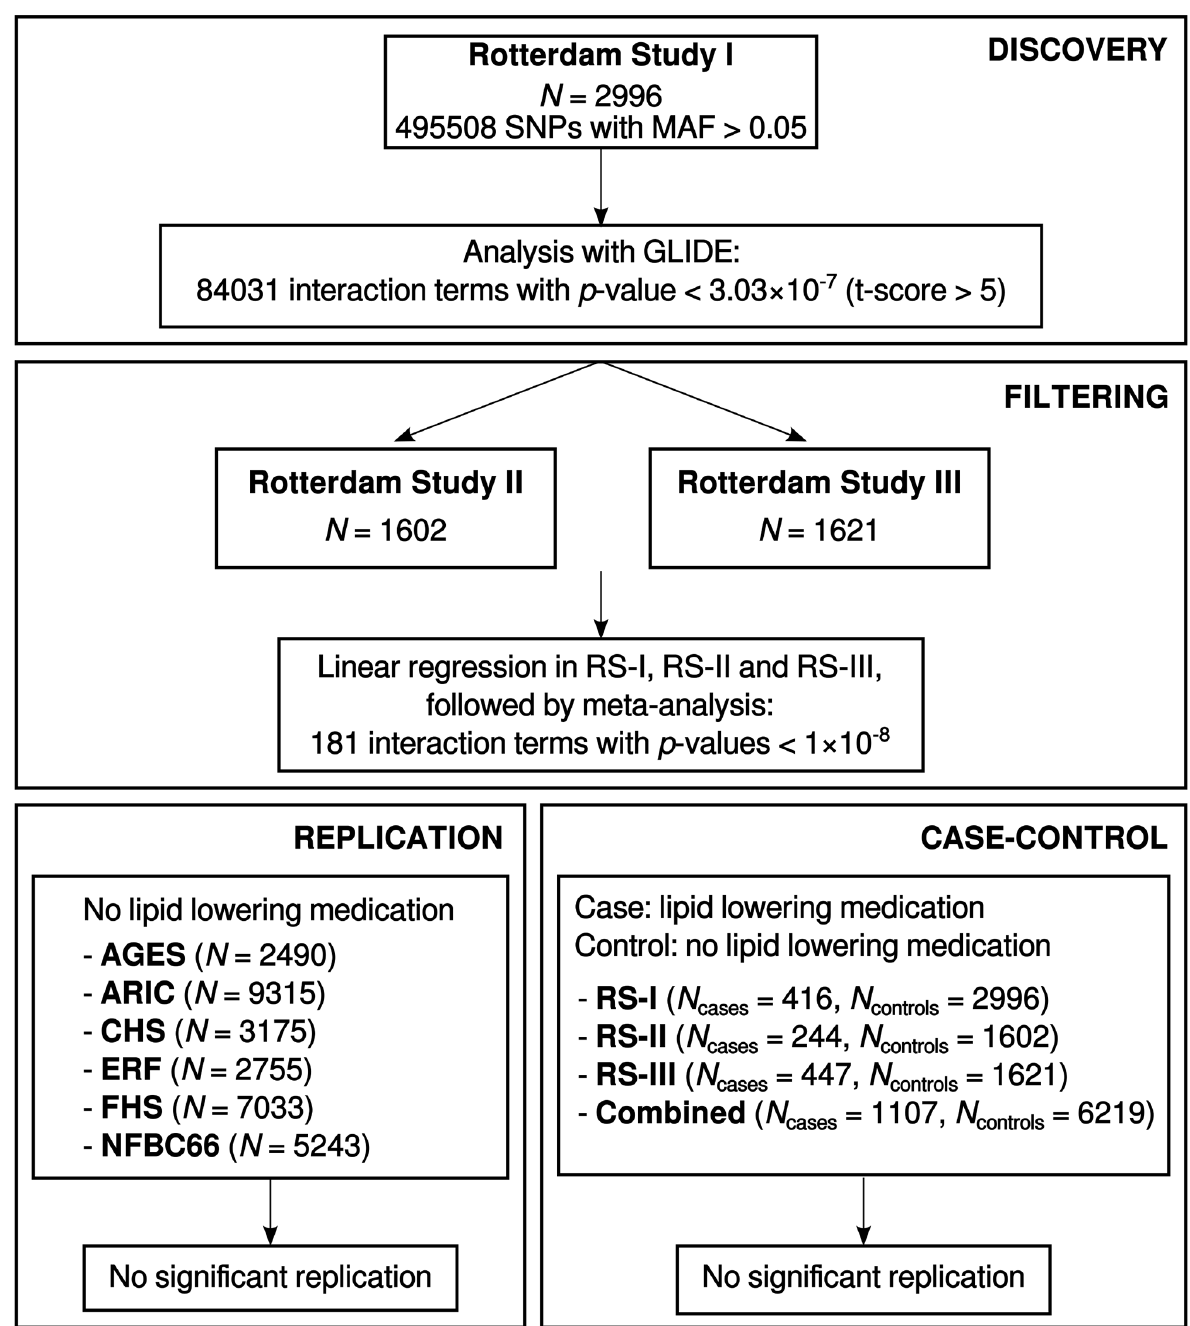
Figure 1. Flow diagram overview of the analysis plan.